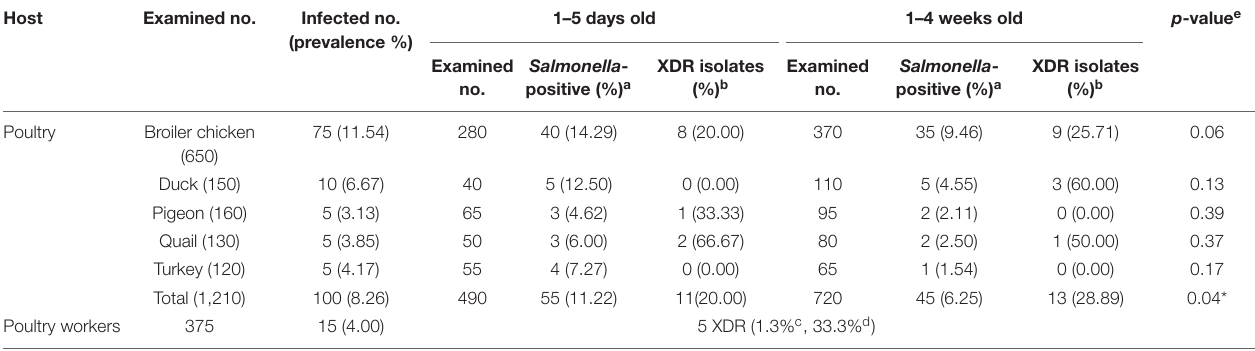
TABLE 1 | Salmonella prevalence and XDR isolates recovered from clinically diseased, recently dead birds, and contact poultry workers. Host Examined no.